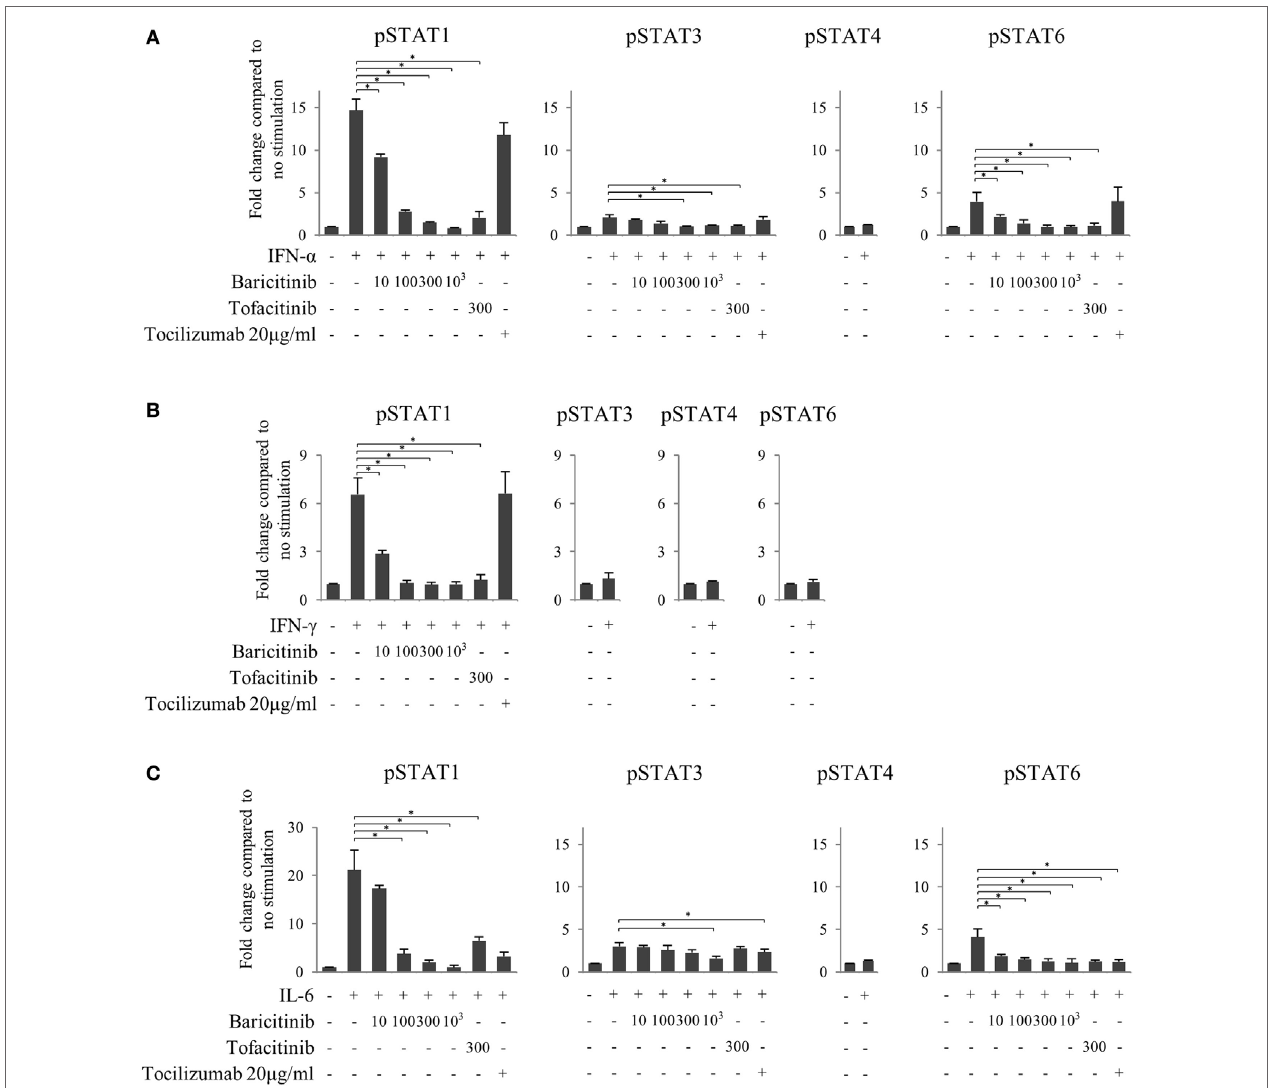
FigUre 7 | Baricitinib inhibits phosphorylation of signal transducer and activator of transcription (STAT) mediated by type-I interferon (IFN), type 2 IFN, and interleukin (IL)-6. Human naive CD4 + T cells were cultured in the presence of various cytokines (IFN- α , IFN- γ , and IL-6). (a) Expression of pSTATs mediated by IFN- α in the presence of baricitinib and other inhibitors. (B) Expression of pSTATs mediated by IFN- γ in the presence of baricitinib and other inhibitors. (c) Expression of pSTATs mediated by IL-6 in the presence of baricitinib and other inhibitors. Data are mean ± SD of three different donors per group. * p < 0.05 (by Mann–Whitney U